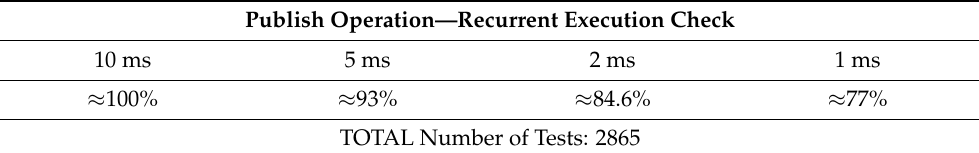
Table 2. DDS Control Node—Native Linux OS—Publish Operation.